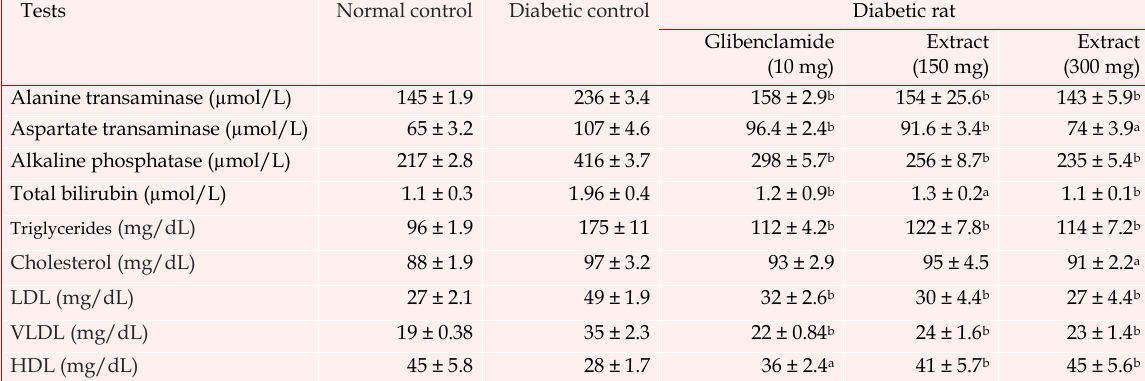
Effect of I. aucheri methanolic extract on serum enzymes, total bilirubin and lipid profile